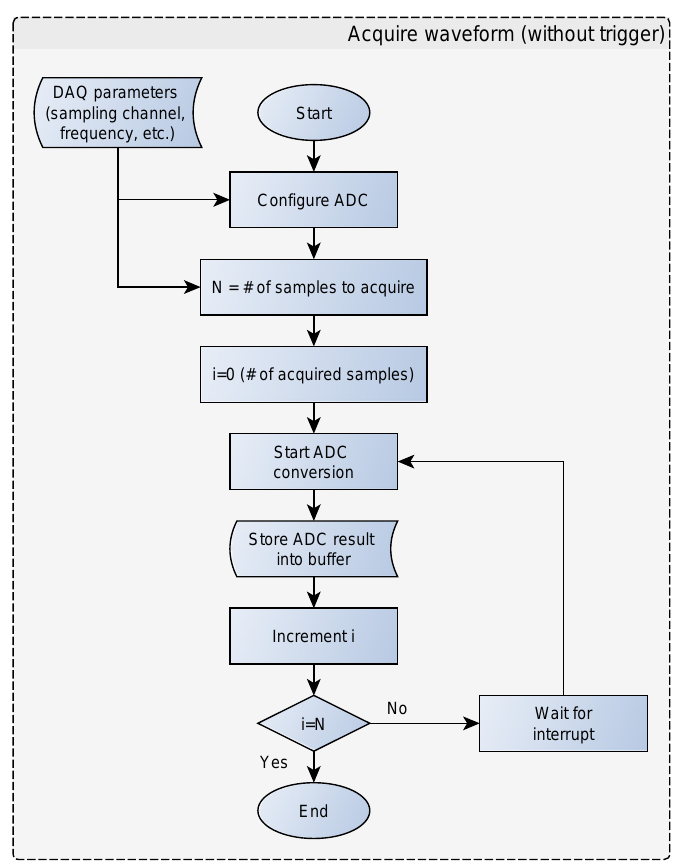
Figure 5 . SimpleDAQ firmware flowchart: Waveform acquisition